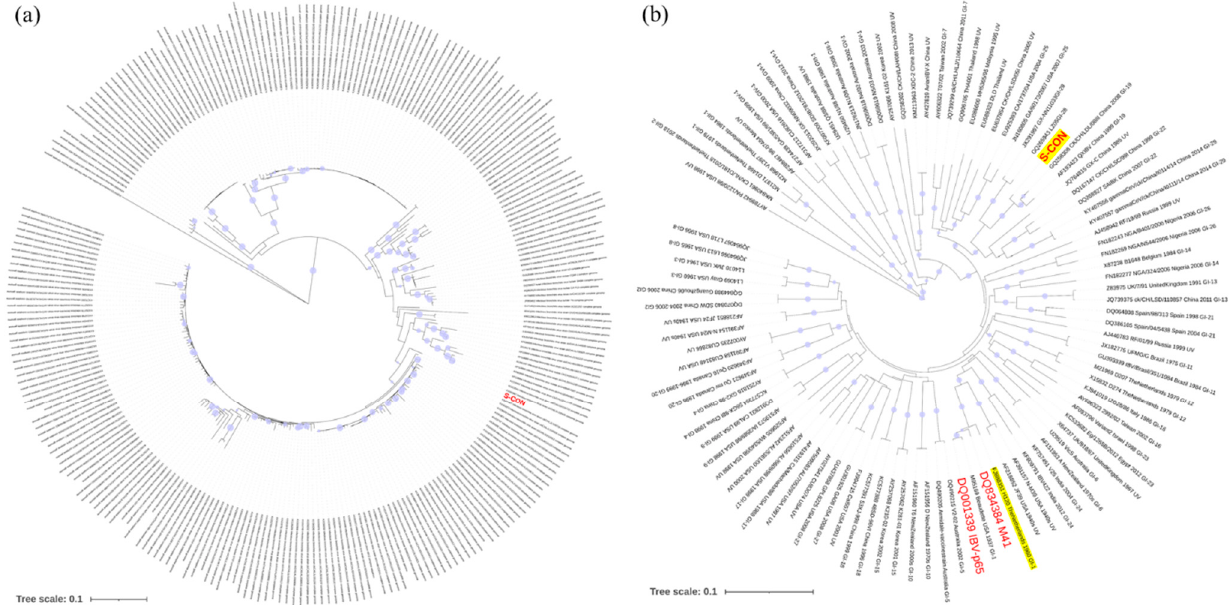
Figure 2. Phylogenetic analysis of the consensus nucleotide sequence of spike protein (S-CON). ( a ) Genetic relatedness of S-CON and indicator strains. A neighbor-joining (NJ) tree illustrated the genetic distances between the S-CON (red) nucleotide sequence and the indicator strains. ( b ) Genotypes of S-CON and strains used in this study. Bootstrap values ( n = 1000 replicates) <70% were not shown.